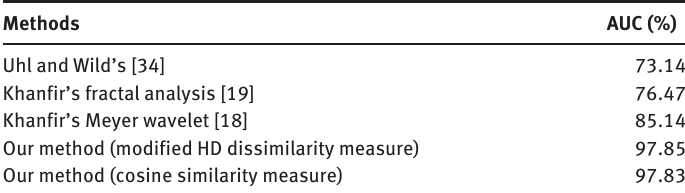
Table 1. Performance Comparisons on the CASIA-IrisV3-Interval